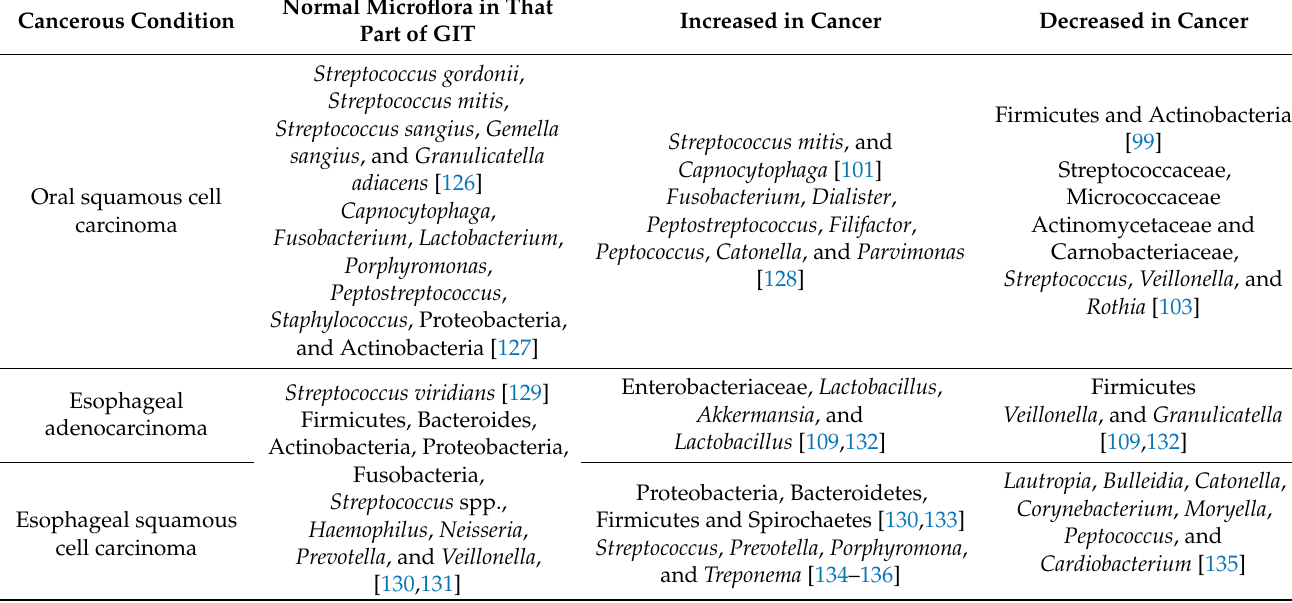
Table 2 illustrates dysbiosis in GIT cancers. Table 2. Dysbiosis in GIT